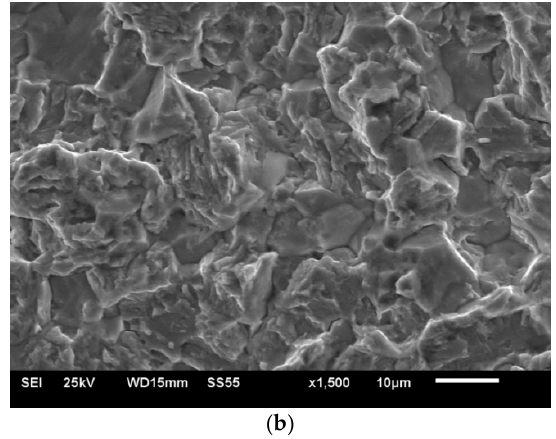
Figure 13. Typical Fatigue Fracture Surface Features Present in the Austempered 4140 Samples at low ∆ K Values. ( ∆ K = 19 MPa √ m; crack growth direction was from top to bottom of photos). ( a ) Uncharged (No Hydrogen); ( b ) Hydrogen-Charged.